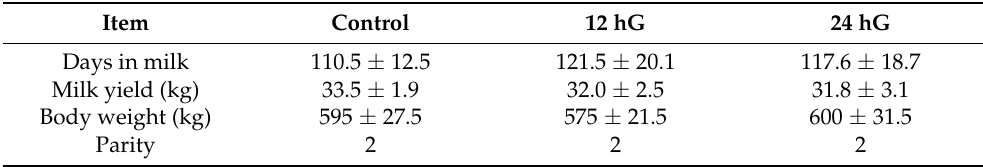
Table 1. Average days in milk, milk yield, body weight, and parity of dairy cows at the beginning of the experiment ( n = 7).